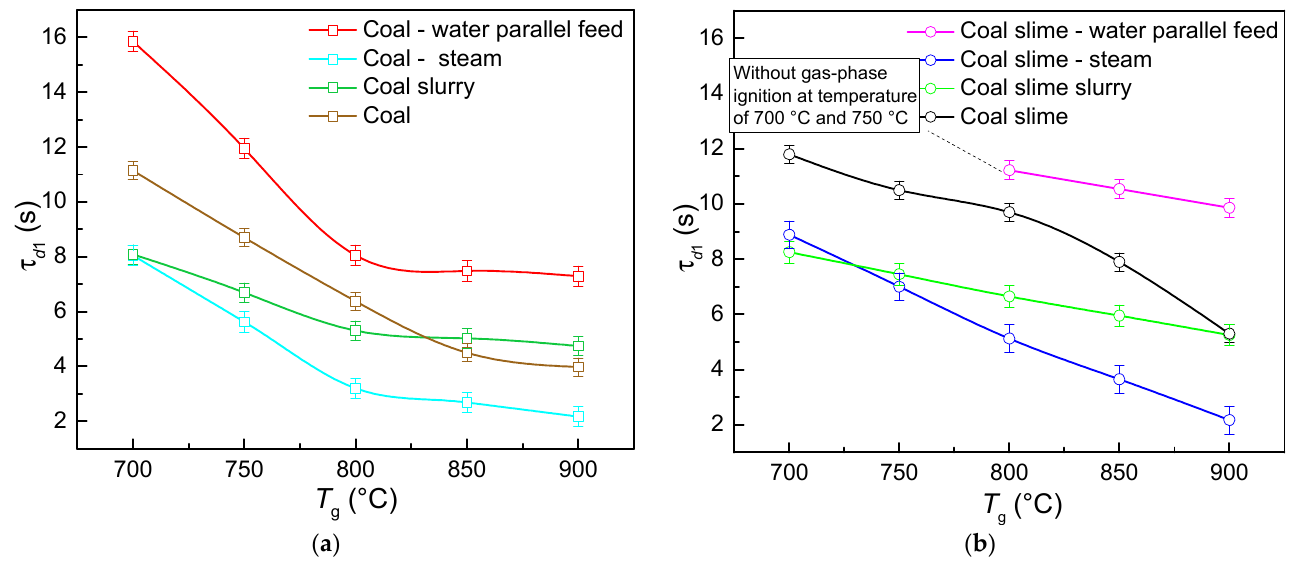
Figure 3. Gas-phase ignition delay times of fuels based on bituminous coal ( a ) and coal slime ( b ) when varying the method of introducing the components and temperature in the combustion chamber.